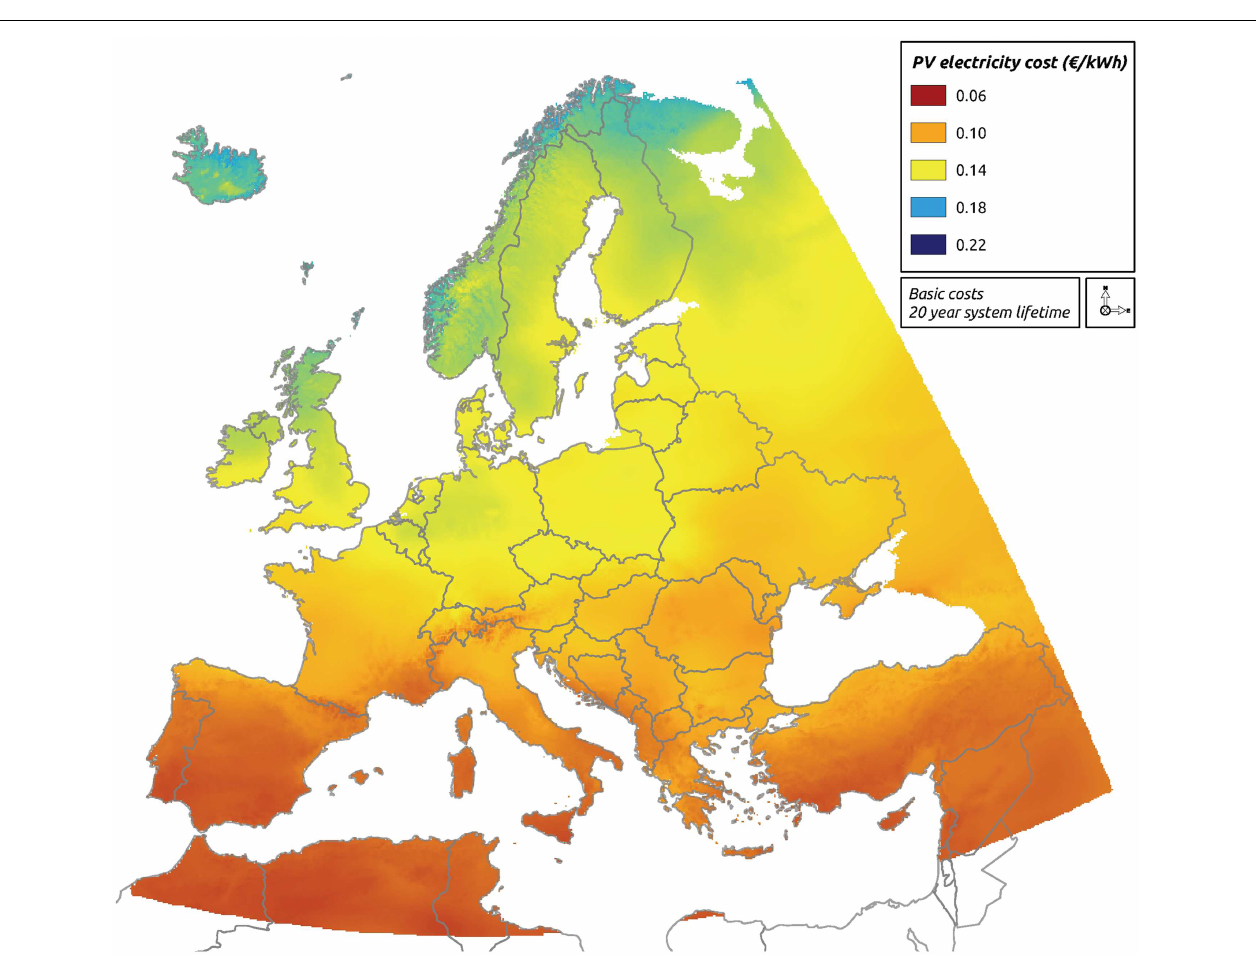
FIGURE 1 | Basic costs of PV electricity in Europe for a 20-year system lifetime .